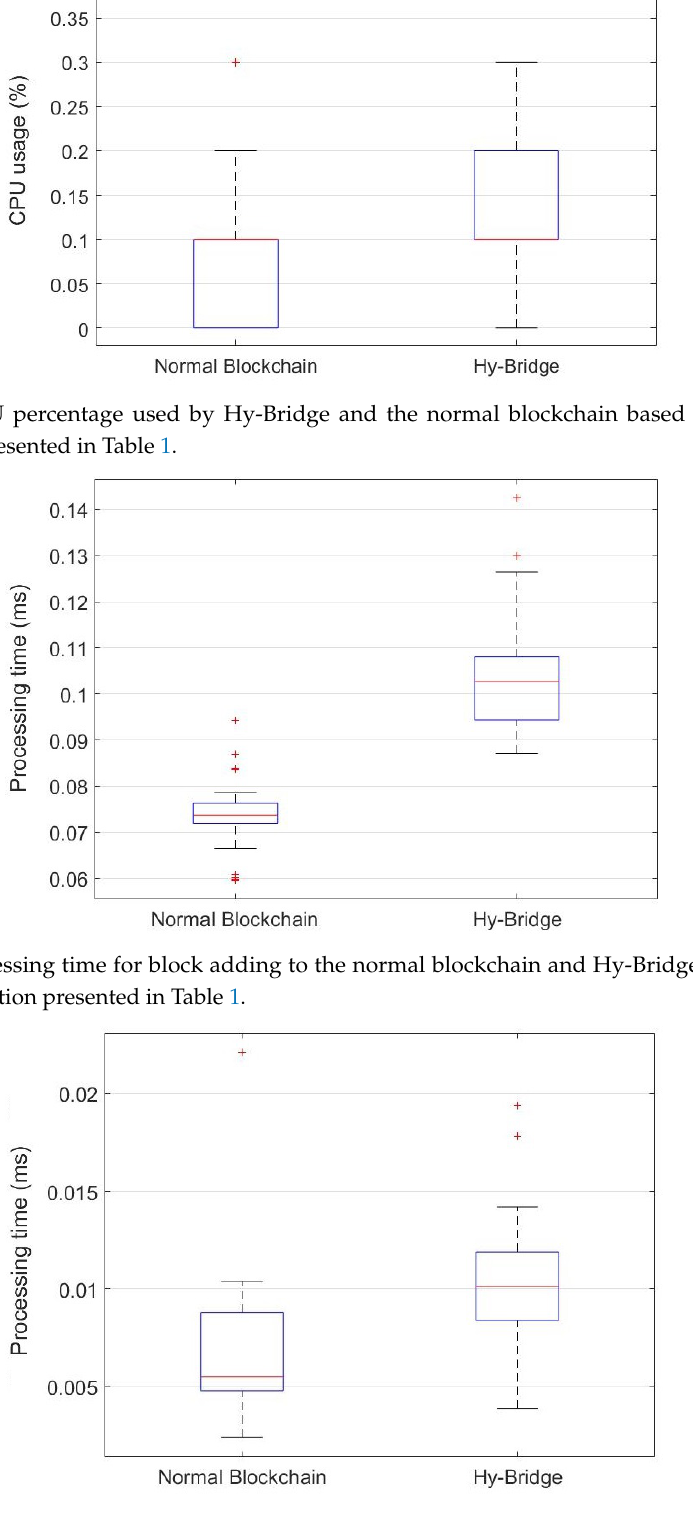
Figure 12. Processing time for block validating in the normal blockchain and Hy-Bridge based on IoT power consumption presented in Table